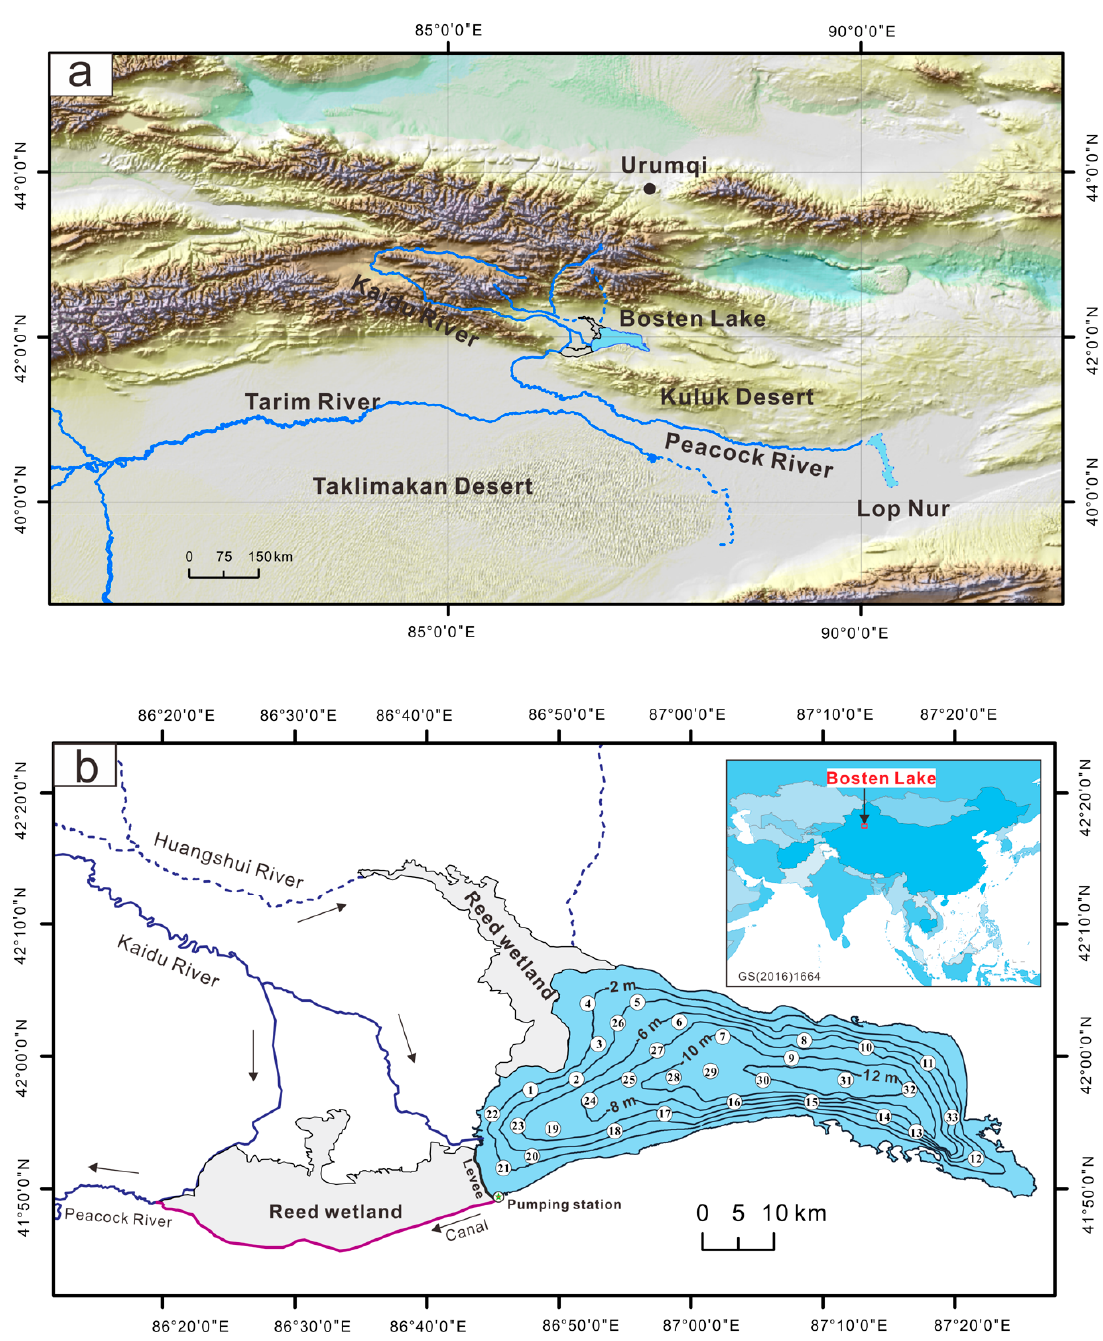
Figure 1. ( a ) The river water system of the Bosten Lake and ( b ) the distribution of sampling sites in Bosten Lake.